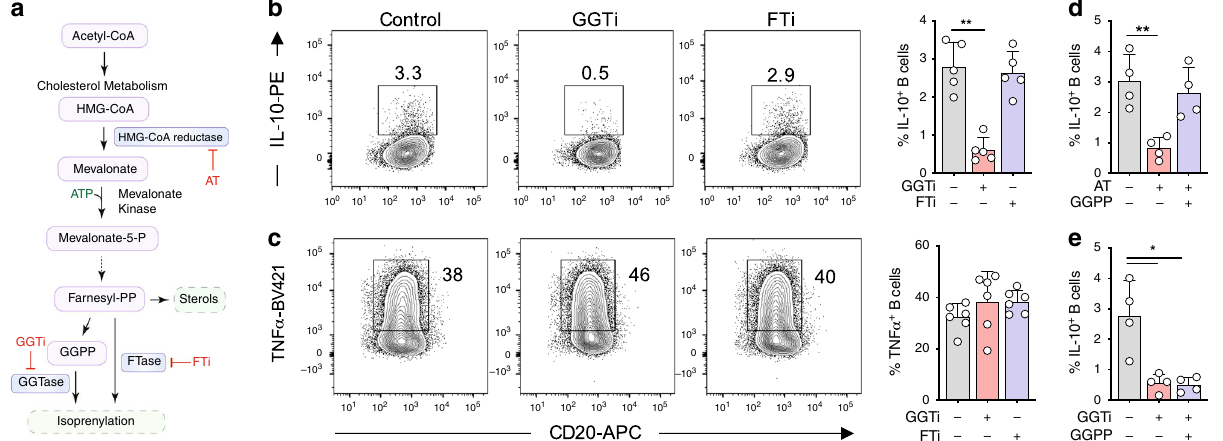
Fig. 2 Cholesterol metabolism drives IL-10 via GGPP. a Schematic diagram showing key metabolites and enzymes of the isoprenylation route in cholesterol metabolism. b , c IL-10 ( b ) and TNF ( c ) expression in human B cells after stimulation through TLR9 ± geranylgeranyl transferase inhibition (GGTi, GGTi-298) ± farnesyl transferase inhibition (FTi, FTi-277) ( n = 5 for IL-10, pval = 0.001; n = 6 for TNF). d IL-10 expression in human B cells after stimulation through TLR9 ± atorvastatin (AT) ± geranylgeranyl pyrophosphate (GGPP) ( n = 4, pval = 0.009). e IL-10 expression in human B cells after stimulation through TLR9 ± GGTi ± GGPP ( n = 4, pval both 0.03). Each data point represents individual donors. All data presented are mean ± SD. Statistical testing in all fi gures was done by a Friedman ’ s test with Dunns ’ s multiple comparisons test. * P < 0.05, ** P < 0.01, and all signi fi cant values are of GGTase-II upon TLR9 ligation did not affect IL-10 expression (Supplementary Fig. 5d).